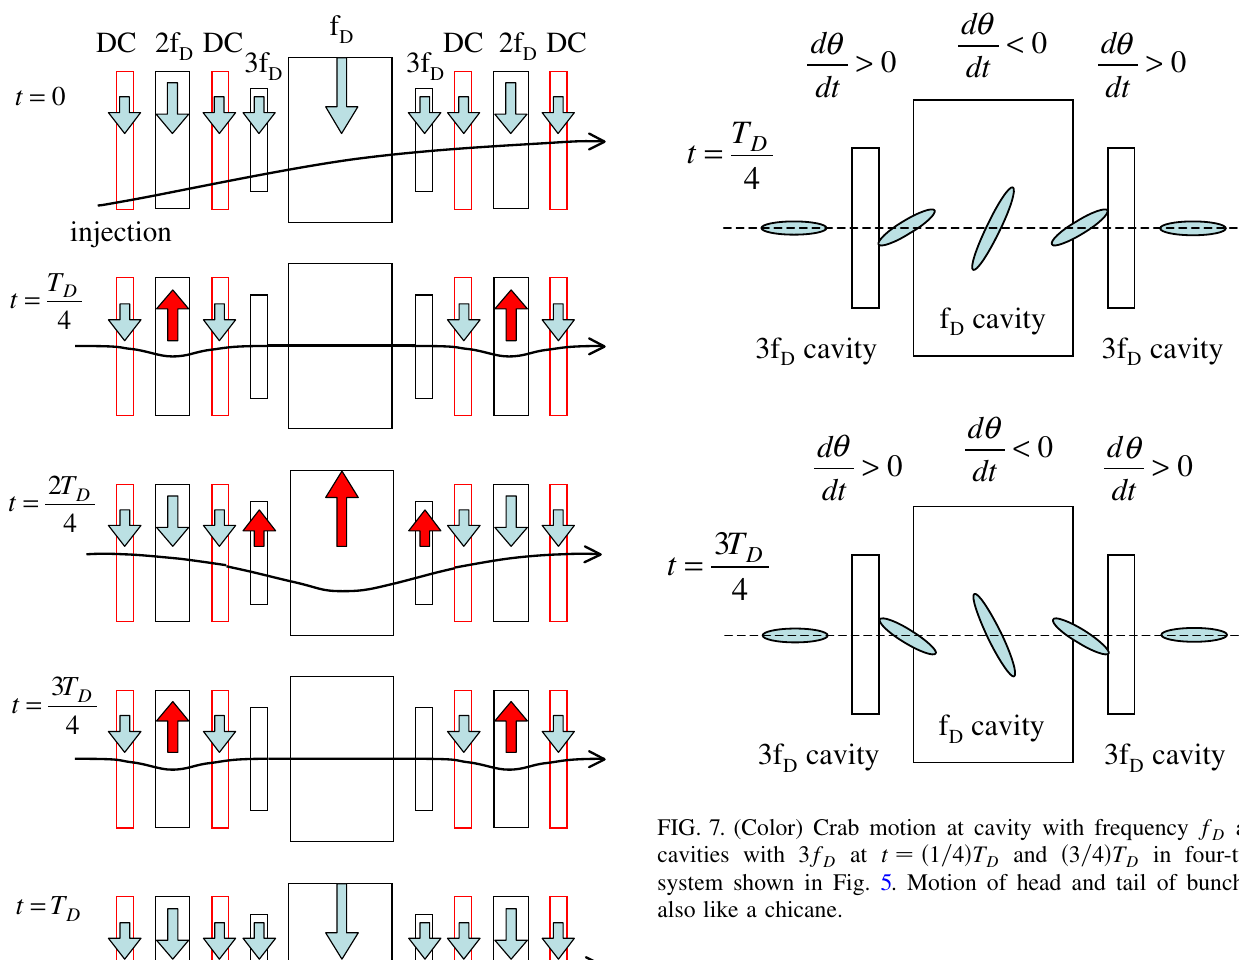
and D at t (cid:3) (cid:1) 1 = 4 (cid:2) T and (cid:1) 3 = 4 (cid:2) T in four-turn D D D